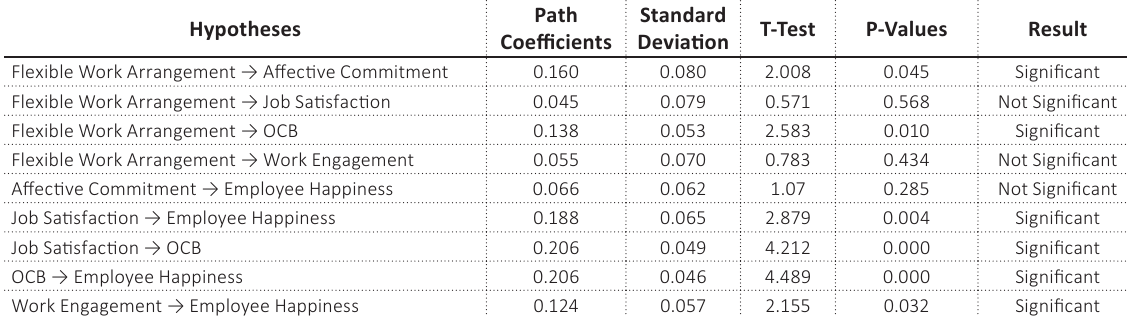
Table 4. Hypotheses